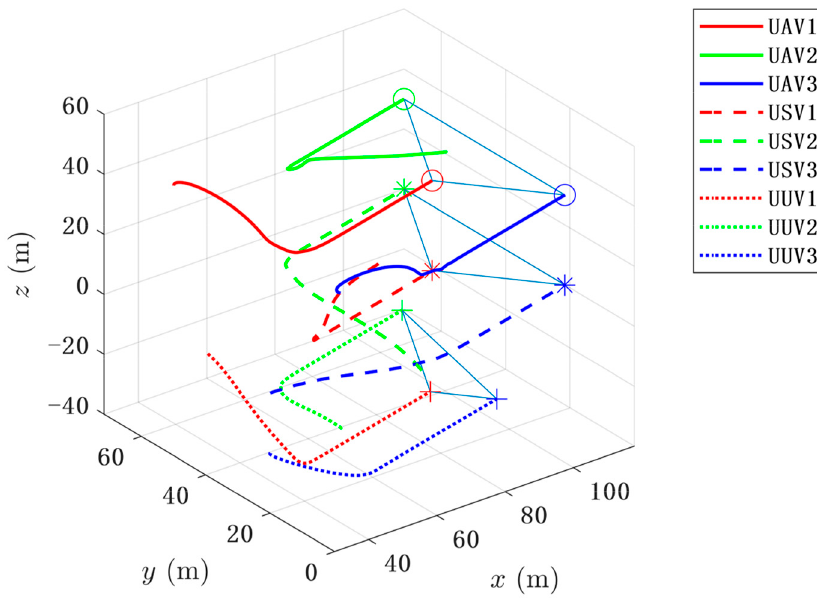
Figure 12. Dynamic formation state with cooperative control and optimal control.